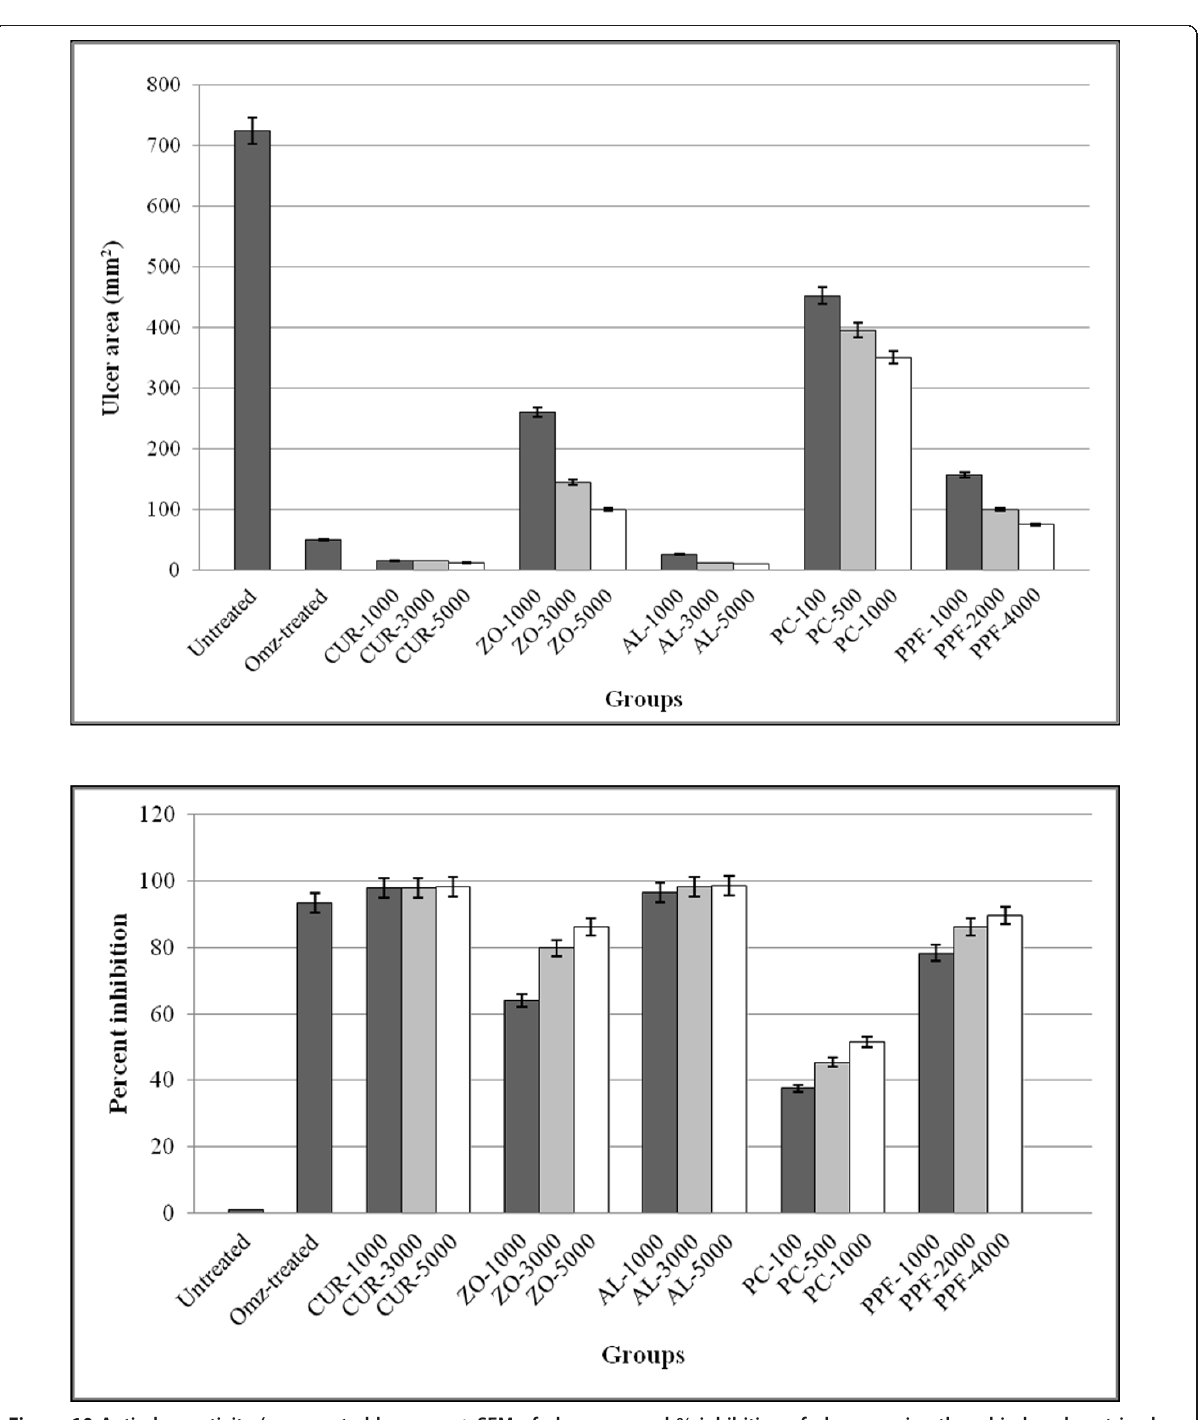
Figure 10 Anti-ulcer activity (represented by mean ± SEM of ulcer area and % inhibition of ulcer area in ethanol-induced gastric ulcer test) of CUR compound and extracts of ZO, AL, PC, and PPF at various dose levels, in comparison with untreated control and omeprazole (reference control) . Statistically significant difference by ANOVA, followed by post hoc scheffe test: CUR-treated group at low dose level vs. control group (p < 0.001). ZO-treated group at medium dose level vs. control group (p < 0.001). AL-treated group at high dose level vs. control group (p < 0.001). PPF-treated group at high dose level vs. control group (p < 0.001). Omeprazole-treated group vs. control group (p <